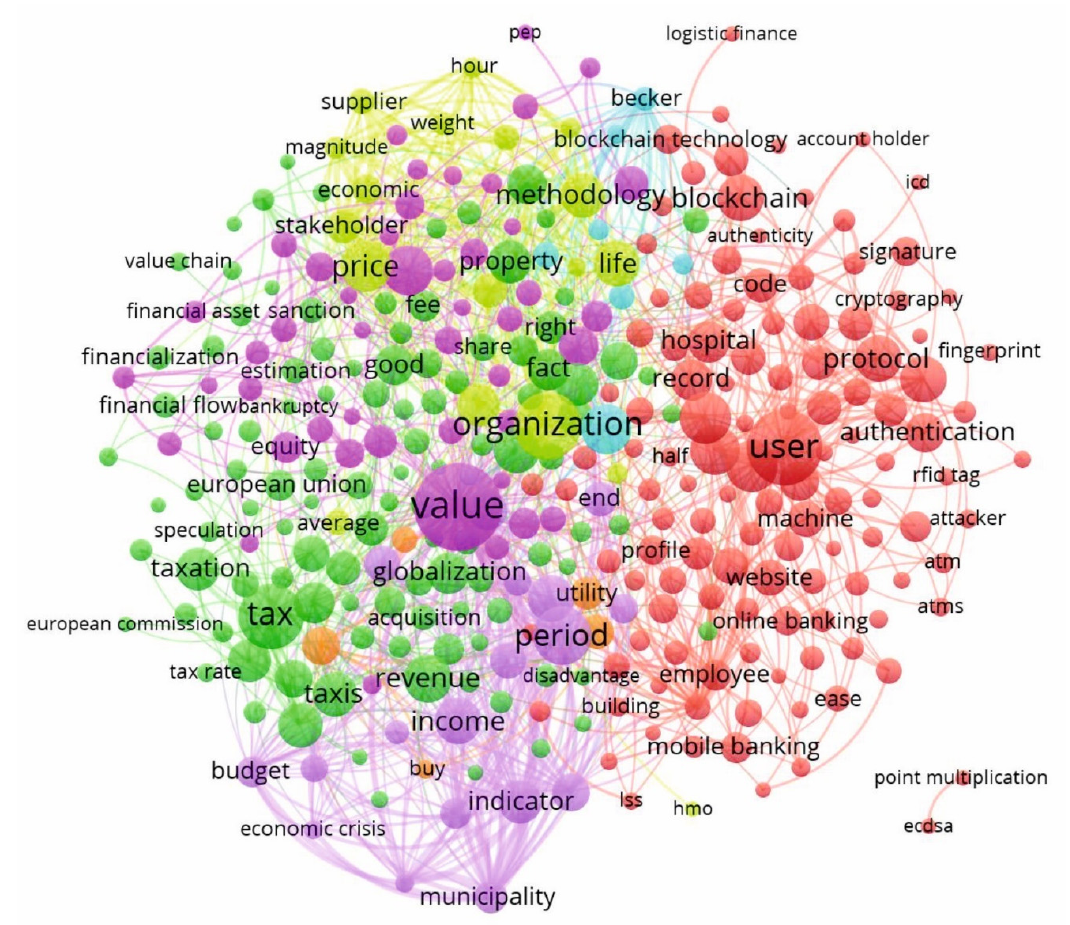
Figure 8. Network of keywords based on co-occurrence.